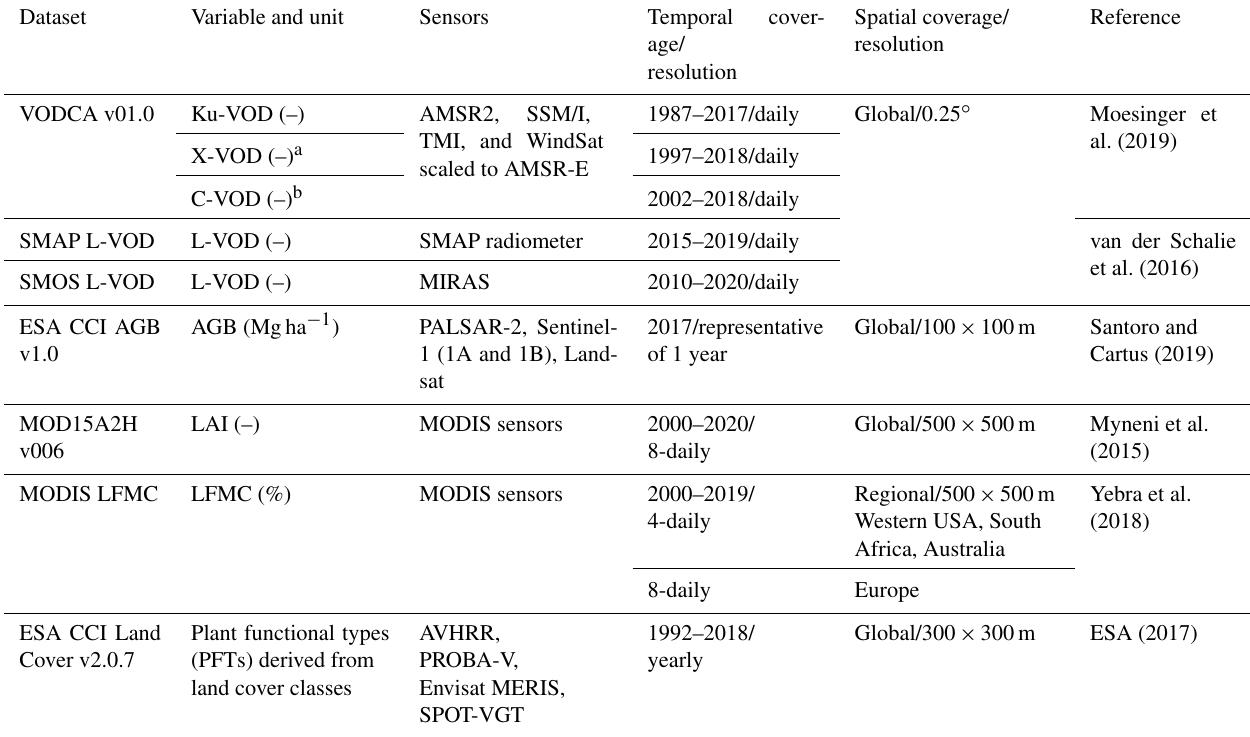
Table 1. Overview of the used datasets and their original technical attributes. AVHRR: Advanced Very High Resolution Radiome- ter. PALSAR-2: Phased Array type L-band Synthetic Aperture Radar 2. PROBA-V: Project for On-Board Autonomy – Vegetation. MERIS: Medium Resolution Imaging Spectrometer. MIRAS: Microwave Imaging Radiometer using Aperture Synthesis. SPOT-VGT: Satel- lite Pour l’Observation de la Terre –